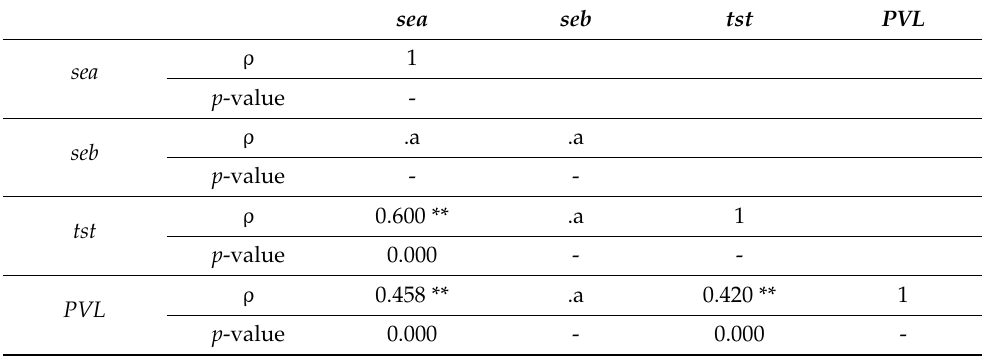
Table 2. Pearson correlation coefficient to assess the pairs of any of two virulence genes detected in biofilm-forming S. aureus isolated from different foods and human hand swab